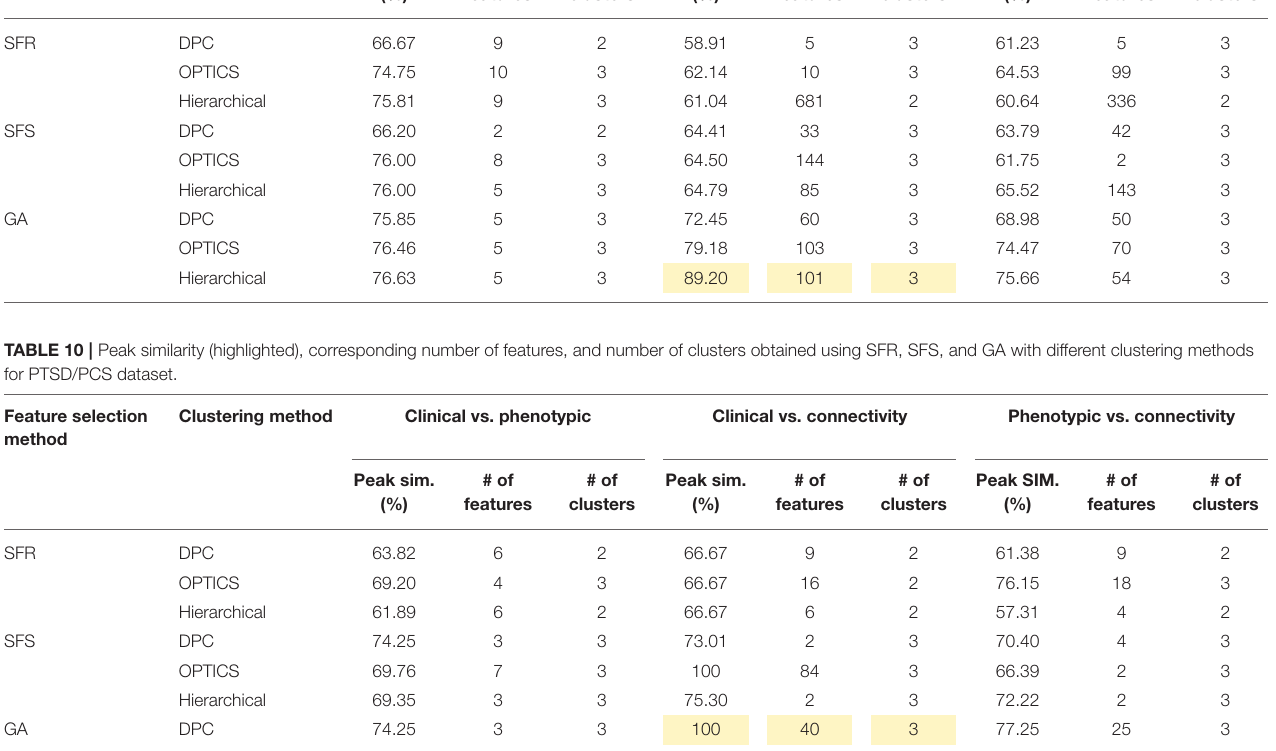
TABLE 9 | Peak similarity (highlighted), corresponding number of features, and number of clusters obtained using SFR, SFS, and GA with different clustering methods for ASD dataset. Feature selection method